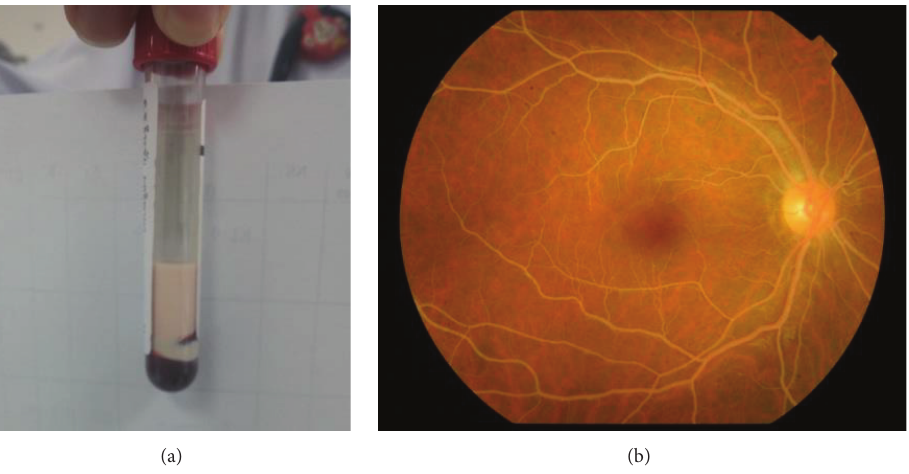
Figure 1: Images describing lipemic serum (a) and lipemia retinals, whitish, creamy vessels of retina